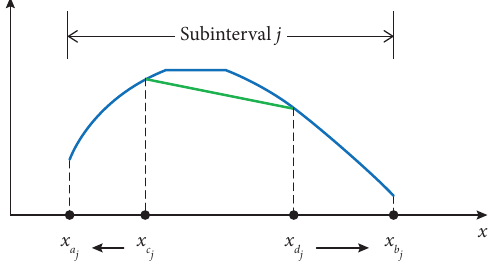
Figure 5: Te illustration of the subinterval. Figure 2. Ten, each section will be divided into several